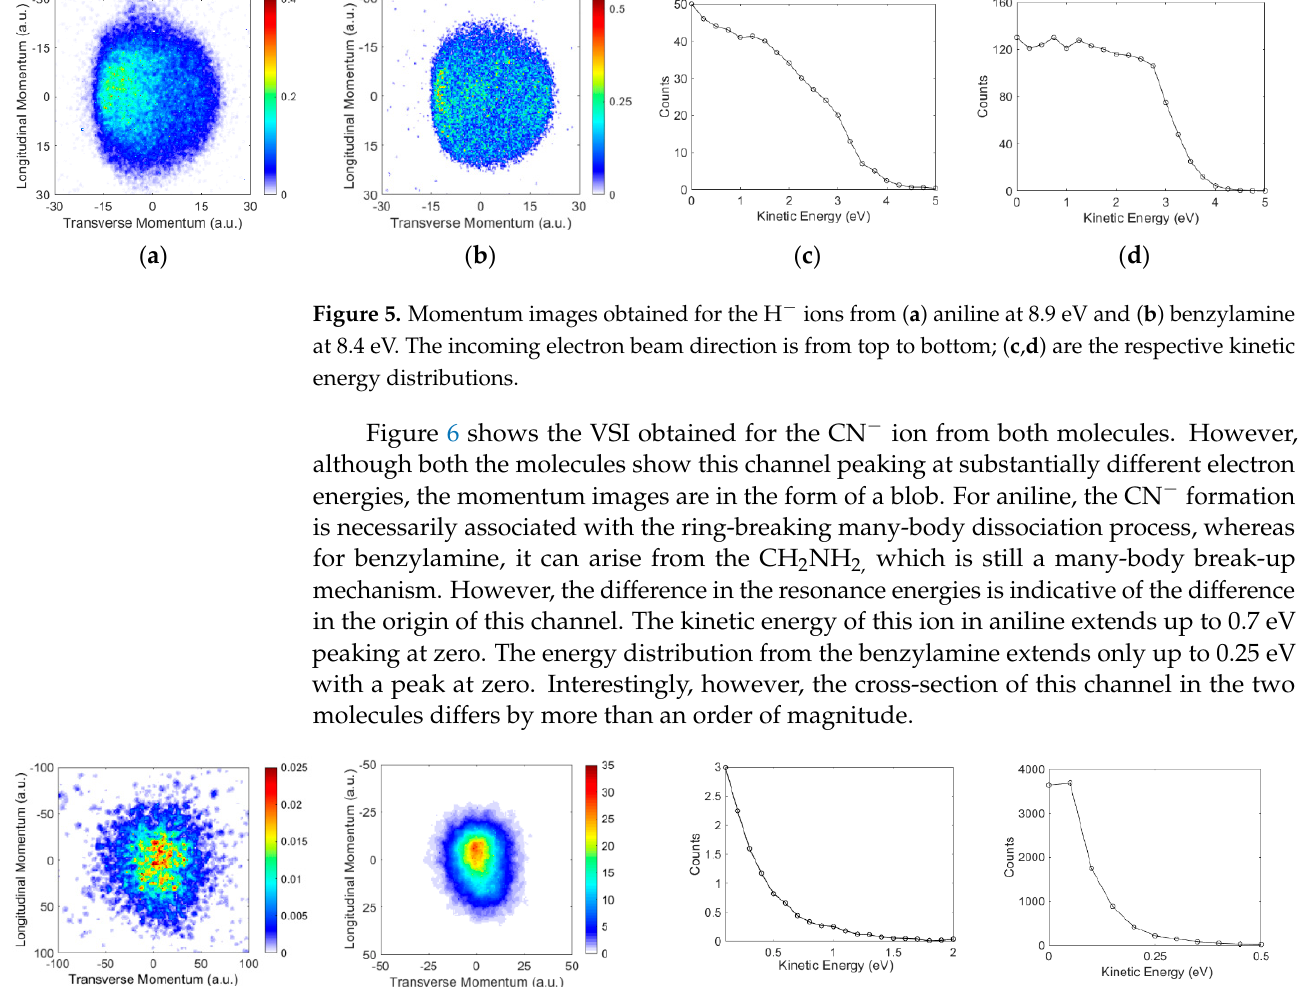
Figure 5. Momentum images obtained for the H (cid:2879) ions from ( a ) aniline at 8.9 eV and ( b ) benzyla- mine at 8.4 eV. The incoming electron beam direction is from top to bottom; ( c , d ) are the respective kinetic energy distributions.